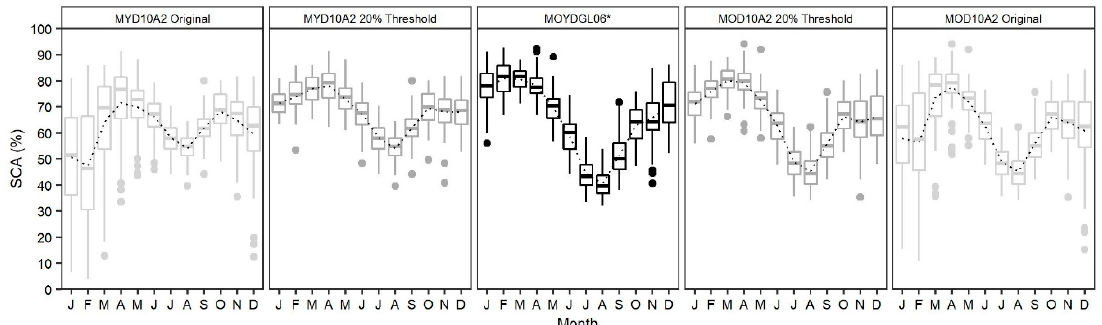
Figure 3. Monthly 8-day SCA variations from 2003 to 2018. The horizontal line inside the rectangular box represents the median, whereas the dotted line represents the mean values, the bottom of the box indicates the first quartile, the top is the third quartile, and the whiskers indicate the range (minimum and maximum values). The dots represent values higher than 1.5 times the upper quartile and usually considered as outliers.